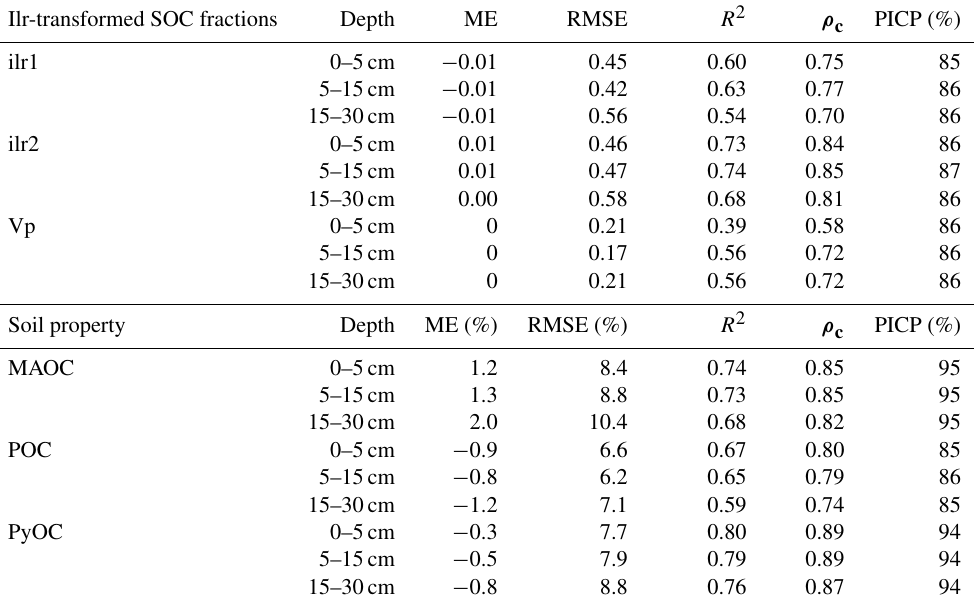
Table 3. Cross-validation statistics for ilr1, ilr2, MAOC, POC, PyOC, and Vp by depth interval. ME, RMSE, R 2 , Lin’s concordance corre- lation coefficient ( ρ c ), and